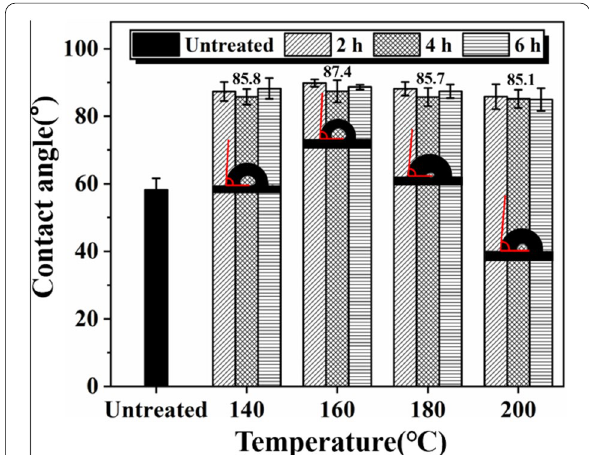
Fig.6 The contact angle of untreated sample and the treated samples at varied temperature (140, 160, 180 and 200 °C) for varied time (2, 4 and 6